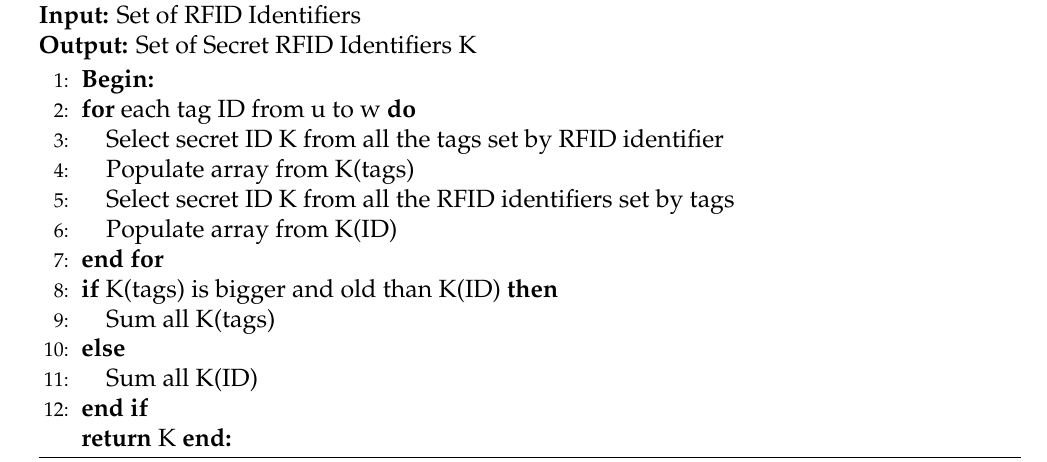
Algorithm 2 Selecting list of secret identifiers